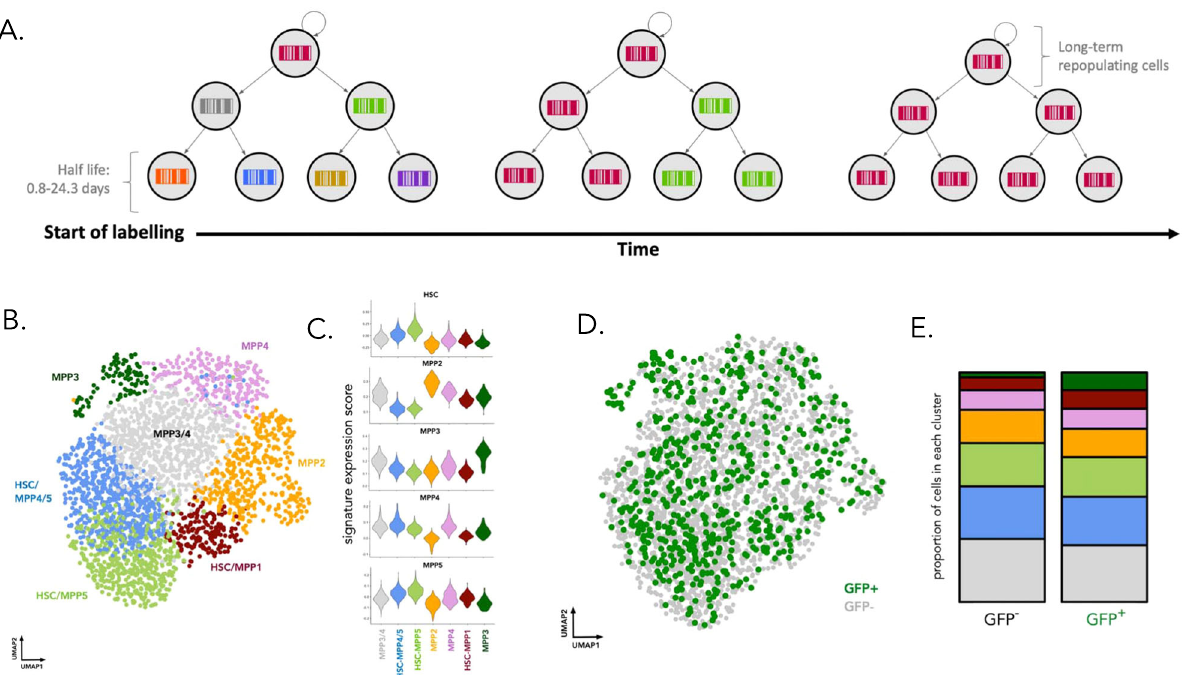
Fig. 2 | Identity of DRAG barcode-labeled HSPC cells. A At the start of DRAG labeling, tamoxifen-induced Cre-ER TM activity will yield DRAG barcodes in stem cells, progenitor cells, and downstream differentiated cells. At later time points (month) after induction, turnover of short-lived committed progenitors and dif- ferentiated cells and replacement by the progeny of long-lived cells has occurred, and DRAG barcodes observed in short-lived differentiated cell pools are derived from long-term repopulating cells. B Six months post tamoxifen induction, HSPC cells (LSK: sca1 + ckit + cells) GFP + and GFP − were scRNA sequenced using the 10×3 ′ end protocol (data from two male DRAG mice induced at 20 weeks). UMAP